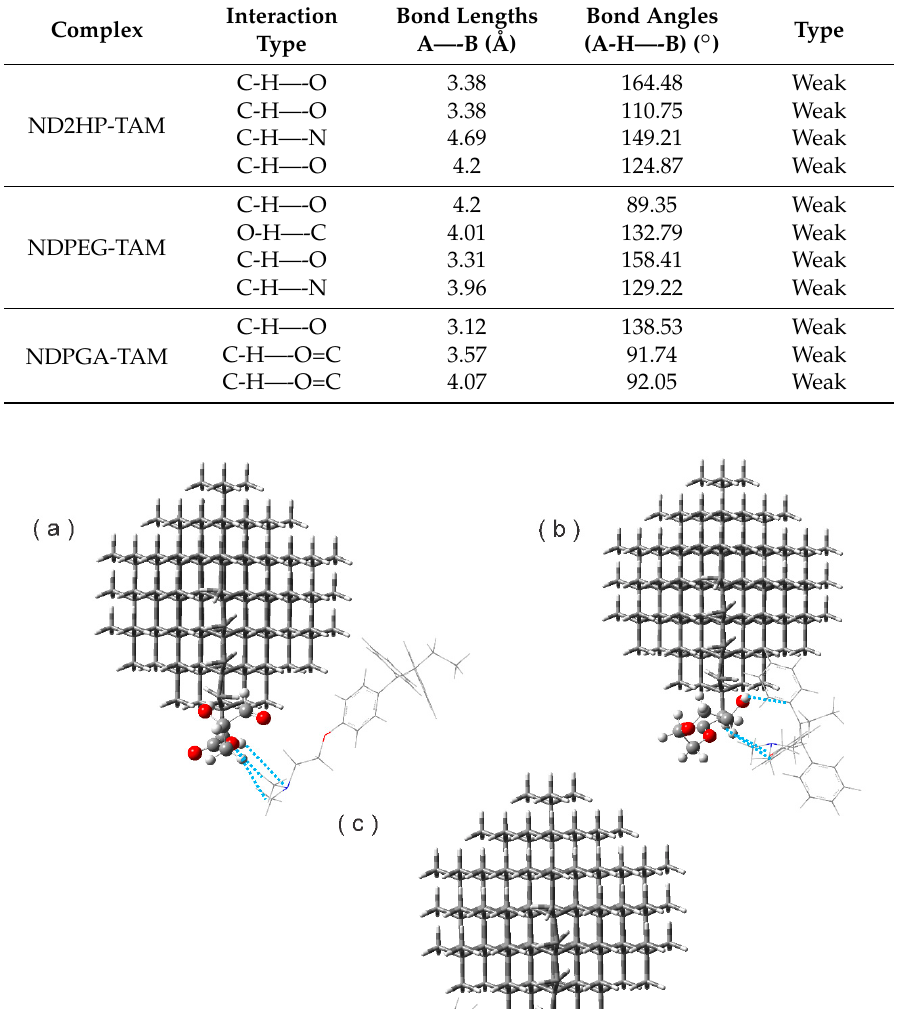
Table 3. Hydrogen bonding in NDE-TAM complexes.